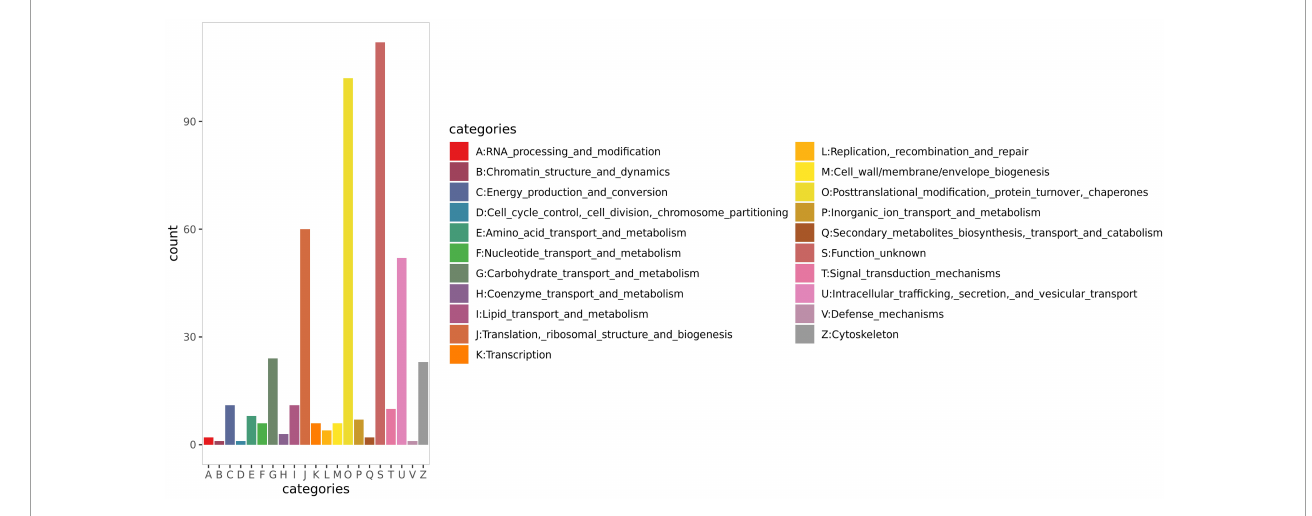
FIGURE3 EggNOG annotation result of human milk caseins from Korean and Han ethnic groups in